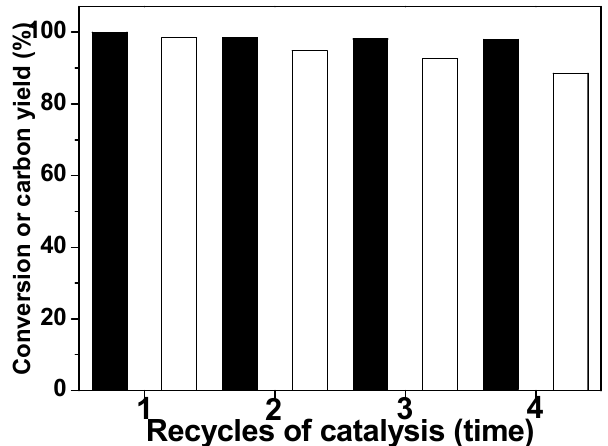
Figure 6. Cyclopentanone conversion (black columns) and carbon yields of 2,5-bis(furan-2-ylmethyl)-cyclopentanone (white columns) and 2,5-bis(2-furylmethylidene)-cyclopentanone (gray columns) over the Pd/C-CaO catalyst. Experimental conditions: 423 K, 10 h, and 4.0 MPa H 2 ; 0.84 g cyclopentanone (10 mmol), 1.92 g furfural (20 mmol), 0.08 g Pd/C-CaO were used for the tests.